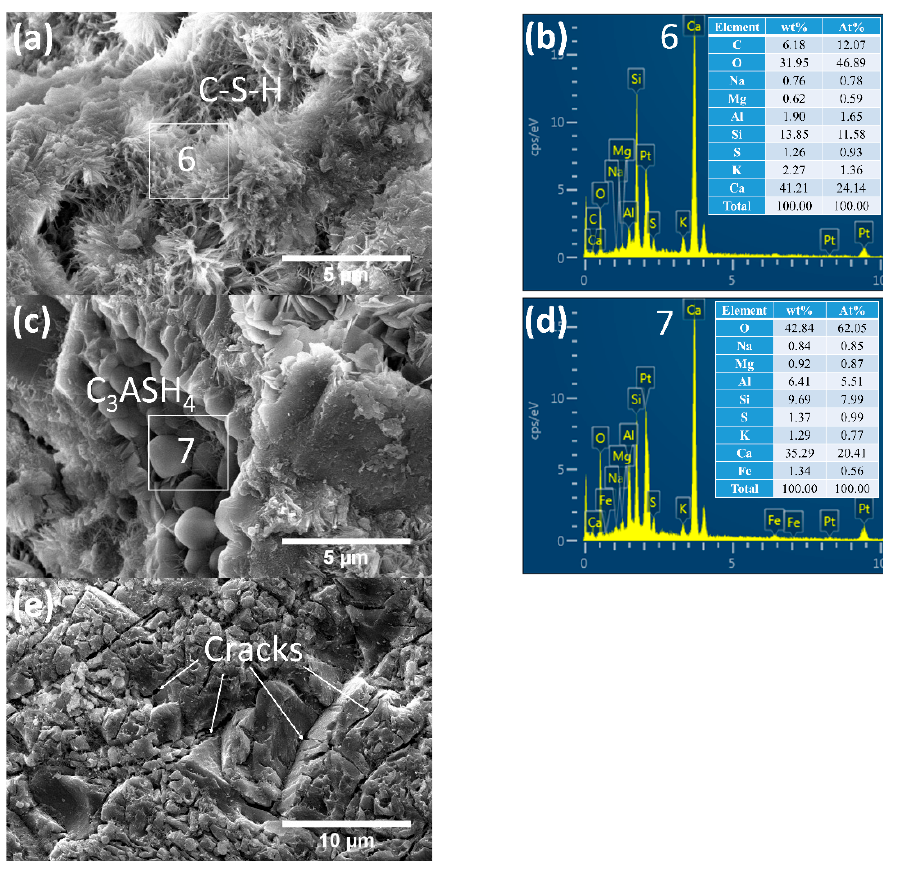
Figure 8. SEM images of cement-GBFS composite binder after 80 °C steam curing for 7 d, ( a ) fibrous C-S-H gels; ( b ) EDS result of area 6; ( c ) spherical hydrogarnet; ( d ) EDS result of area 7; ( e ) cracks.